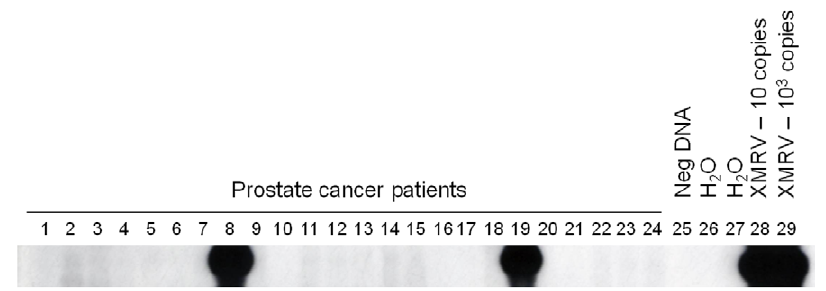
Figure 1. Identification of XMRV sequences in prostate cancer patients. Representative nested pol PCR results using prostate tumor DNA. Lanes 1–24, prostate cancer patients, including patients 5956 (lane 8) and 6203 (lane 19); lane 25, negative human PBMC DNA control; lanes 26 and 27, water only controls for primary and nested PCR tests, respectively; lanes 28 and 29, assay sensitivity controls consisting of 10 and 10 3 copies of XMRV VP62 plasmid DNA diluted in a background of 1 ug of human PBMC DNA,